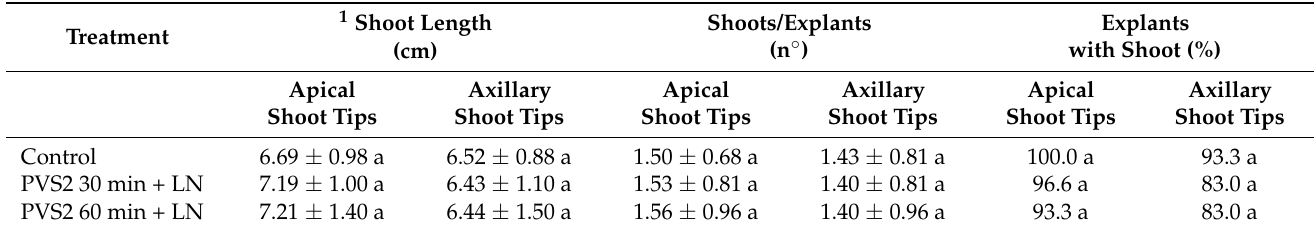
Table 5. Second subculture after V cryo-plate procedure: morphological parameters of S. rebaudiana shoots, from control and from cryopreserved apical shoot tips and axillary shoot tips. (Means ± SD).